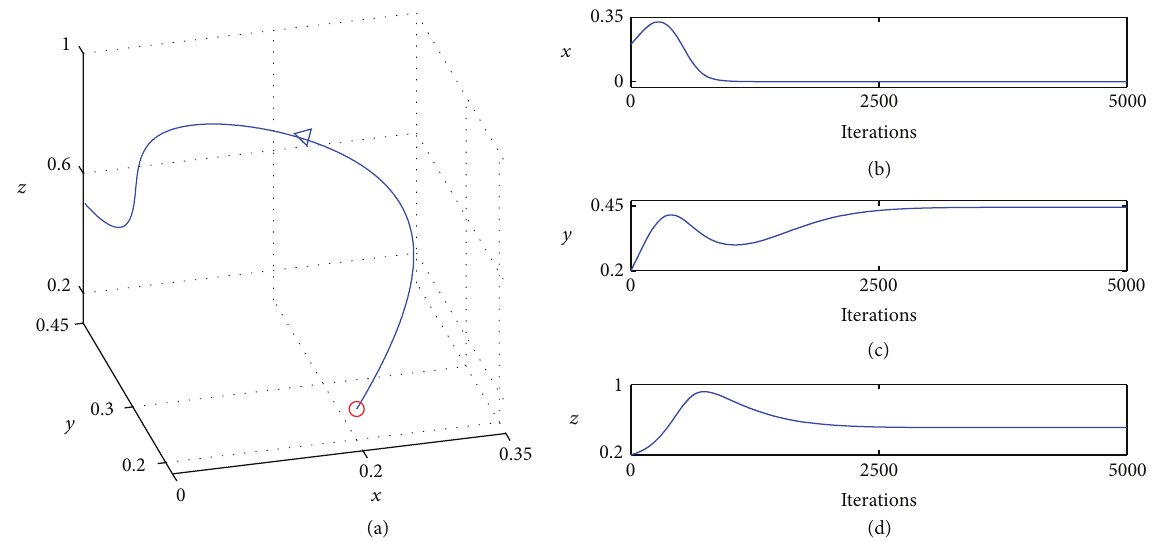
Figure 1: (a) A phase portrait of system (1) with initial condition (0.2,0.2, 0.2) and (b)–(d) time series for 𝑥 1 (𝑡), 𝑥 2 (𝑡) , and 𝑦(𝑡) , respectively, when 𝑎 1 = 0.8, 𝑏 1 = 1, 𝑎 2 = 0.7, 𝑏 2 = 1, 𝑐 = 0.5, 𝑑 = 0.2, 𝑒 1 = 0.8, 𝑒 2 = 0.9, 𝛼 = 1.3 , and 𝛽 = 0.5 .